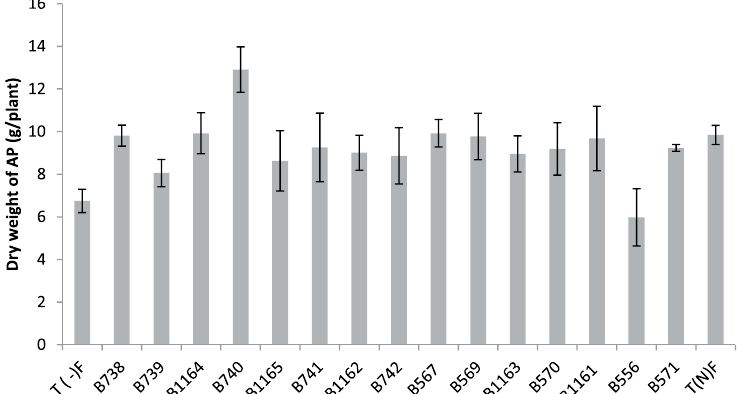
Fig. 2. Shoot Dry weight of the plants inoculated with different rhizobial strains obtained from nodules of legumes isolated from the city of Fez and its regions. All data represent the mean ± SD of three replicates.